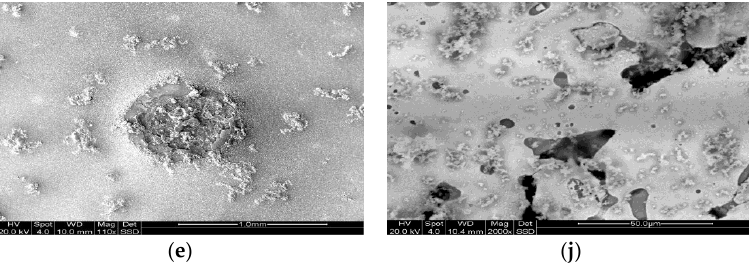
Figure 5. SEM micrographs of the sintered Fe–28Mn-based alloys immersed in SBF solution for different durations: ( a ) Fe–28Mn-3Si alloy with no immersion; ( b ) Fe–28Mn-3Si alloys immersed for 15 days; ( c ) Fe–28Mn-3Si alloys immersed for 30 days; ( d ) Fe–28Mn-3Si alloys immersed for 45 days; ( e ) Fe–28Mn-3Si alloys immersed for 60 days; ( f ) Fe–28Mn alloy with no immersion; ( g ) Fe–28Mn alloys immersed for 15 days; ( h ) Fe–28Mn alloys immersed for 30 days; ( i ) Fe–28Mn alloys immersed for 45 days; ( j ) Fe–28Mn alloys immersed for 60 days. (Note: Arrow P, Q, T, R and shaded area S are the focus of interest in the sintered alloys with different immersion durations). Table 2. Average EDS results on the surface of the immersed Fe–Mn-based samples with different immersion times. Type of